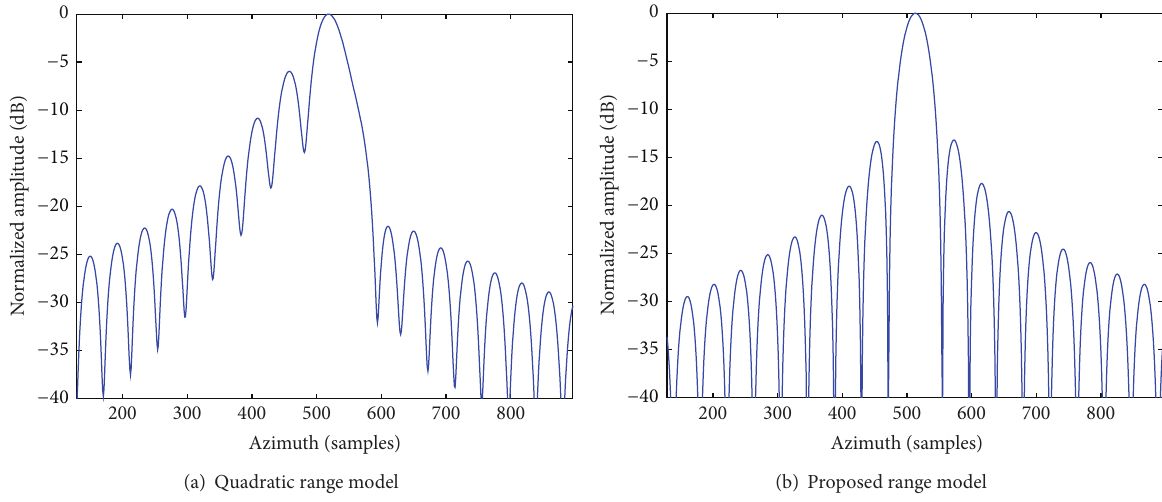
Figure 6: Azimuth impulse responses comparison using different range